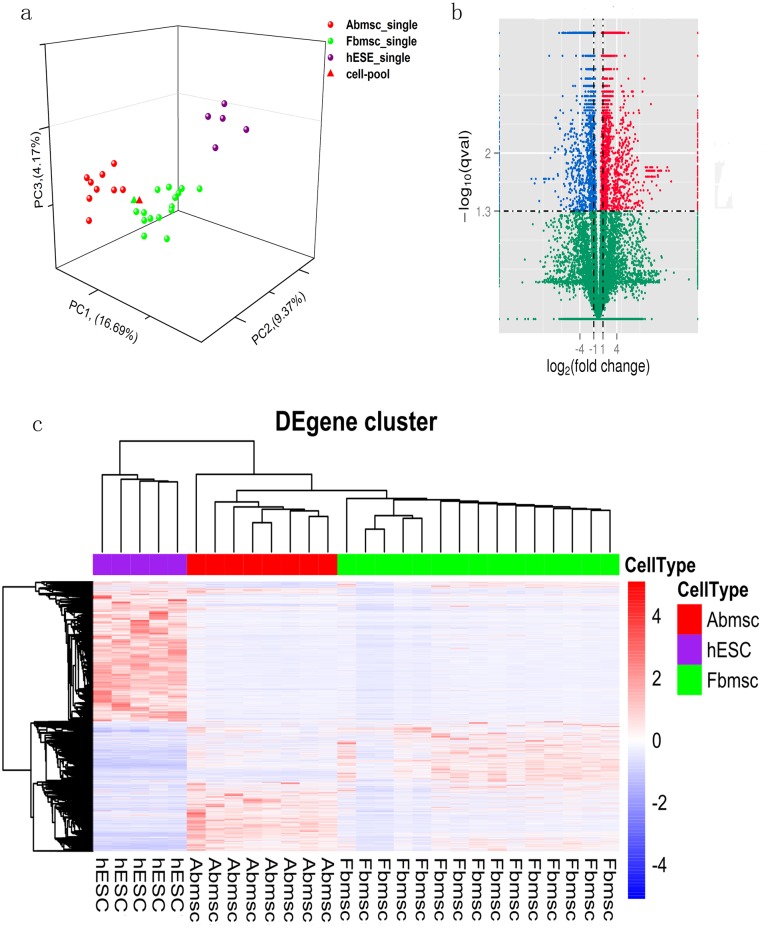
The DEgenes among the three cell lines, a) Principal-component analysis (PCA) of the transcriptome of three different cells. The different color circles indicated the three different cell lines. PCA1, PCA2 and PCA3 represent the top three dimensions of the genes showing differential expression among these cells, which accounts for 16.69%, 9.37% and 4.17% of the expressed RefSeq genes, respectively. b) Volcano plot of genes differentially expressed in Abmsc and Fbmsc samples. The log2 fold change difference between the samples was represented on the x-axis, and negative log of q-values is represented on the y-axis. Each point represents one gene, which had detectable expression in both samples. The genes differentially expressed in Abmsc compared with Fbmsc were plotted in blue for down-regulated genes and red for up-regulated genes, and non-significant genes are shown as green points. c) Clusters of genes showing representative expression patterns during three cell lines. We selected all of the genes that were differentially expressed between any two samples (fold change > 2 or <0.5, P < 0.01).